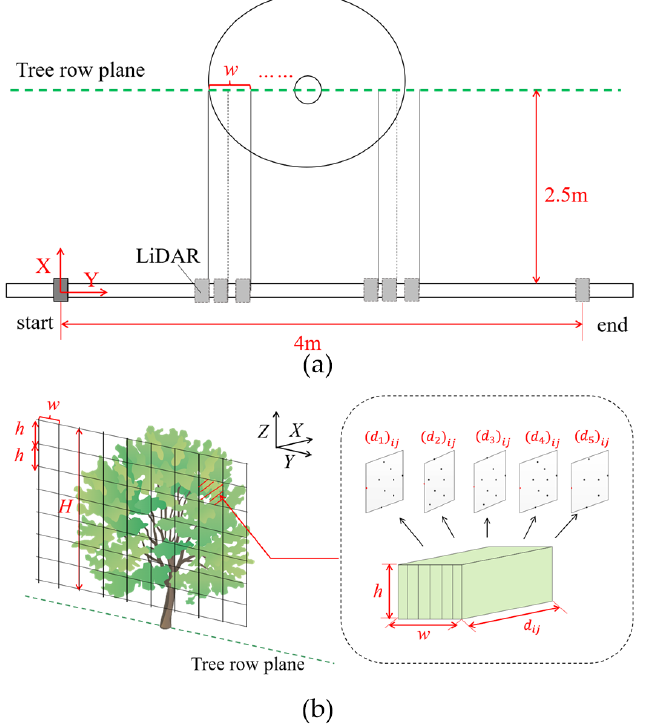
Figure 3. Detection principle of the CADA method: ( a ) Lidar data acquisition; ( b ) canopy volume calculation.